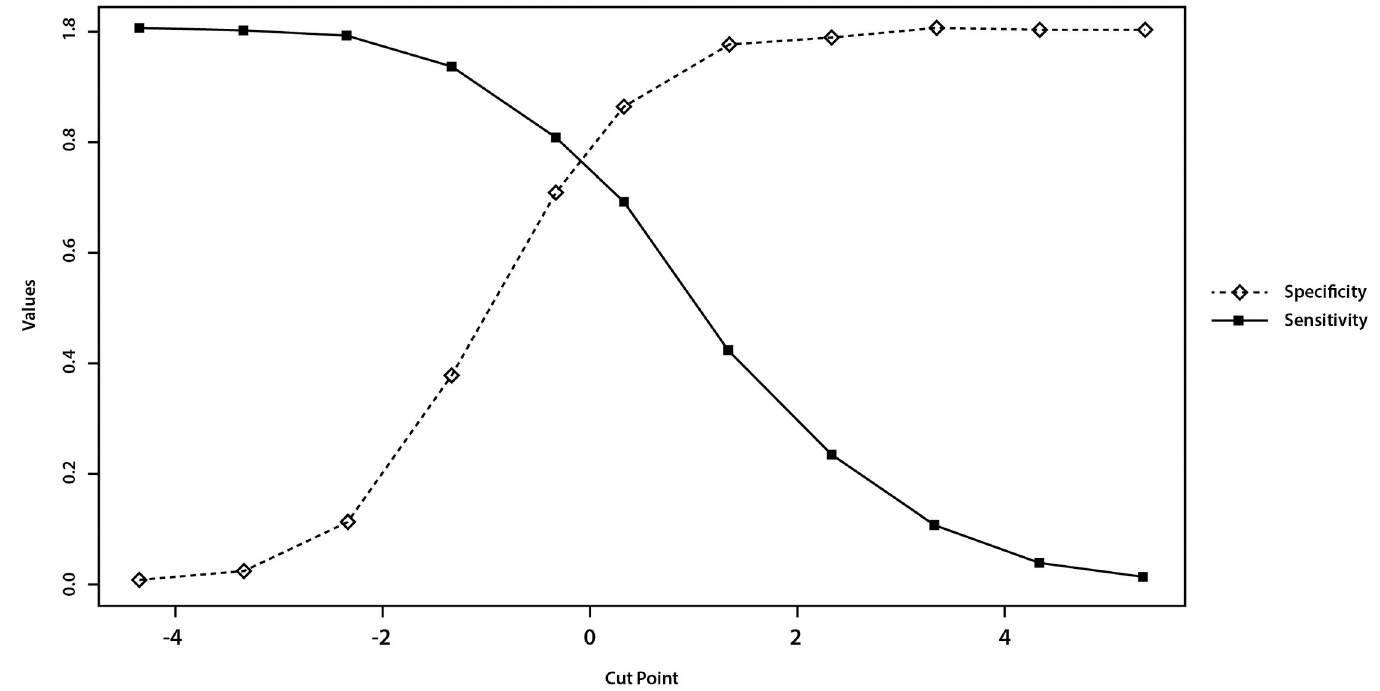
Fig 2. Specificity and sensitivity trade-off at different cut points (weighted coefficients of BMI, C1, C2 and C3).